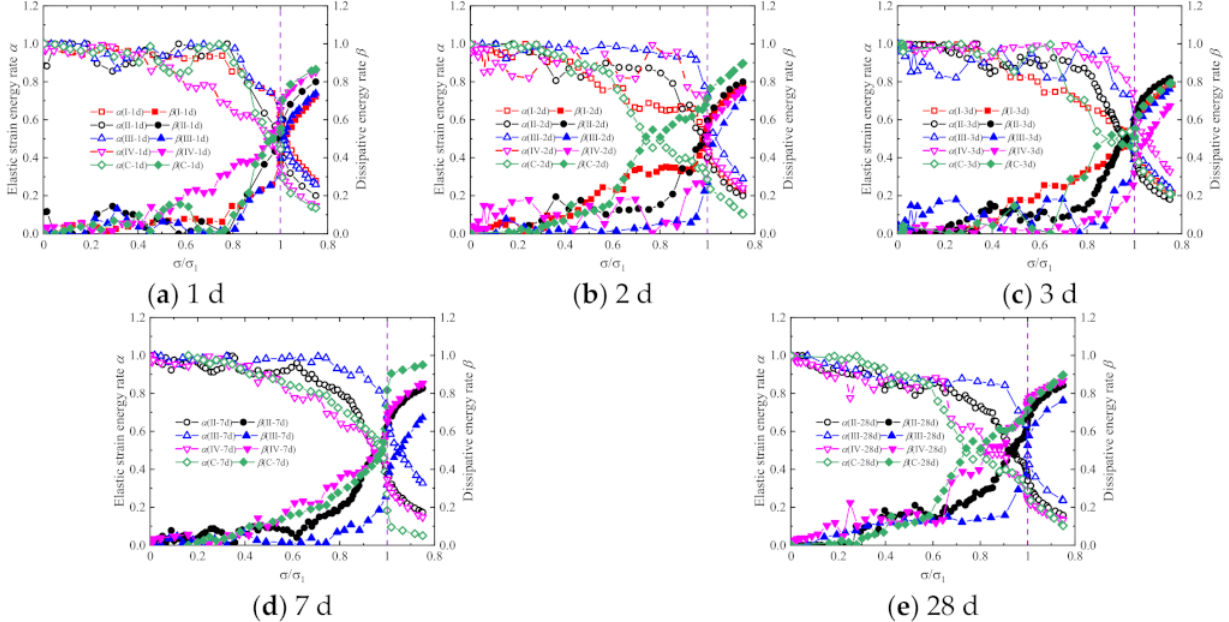
Figure 15. Variations of energy evolution of ( a ) 1 day; ( b ) 2 days; ( c ) 3 days; ( d ) 7 days; and ( e ) 28 days